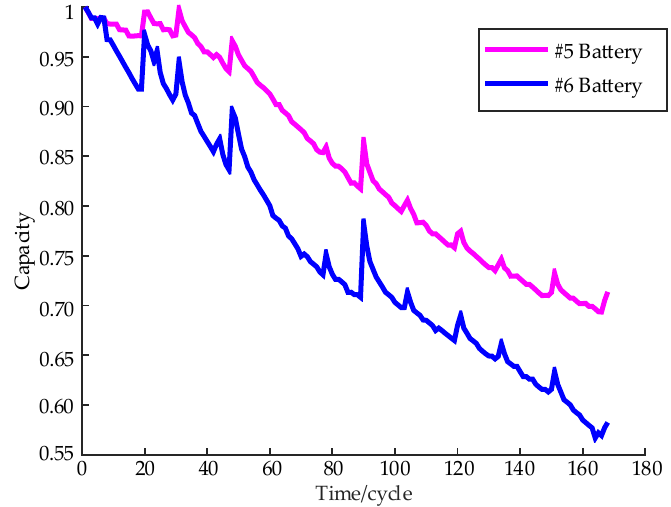
Figure 2. The full charge capacity degradation curves of two batteries (#5, #6).